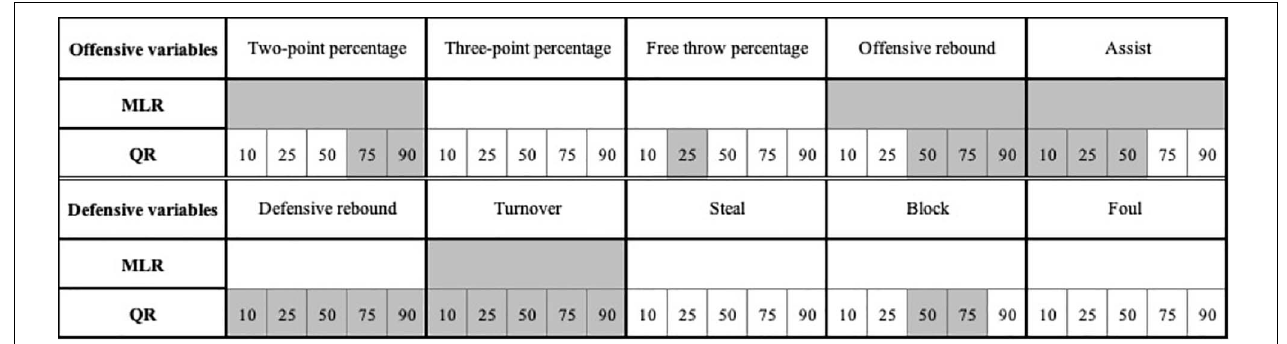
FIGURE 2 | Comparison between MLR and QR modeling for the identified key performance